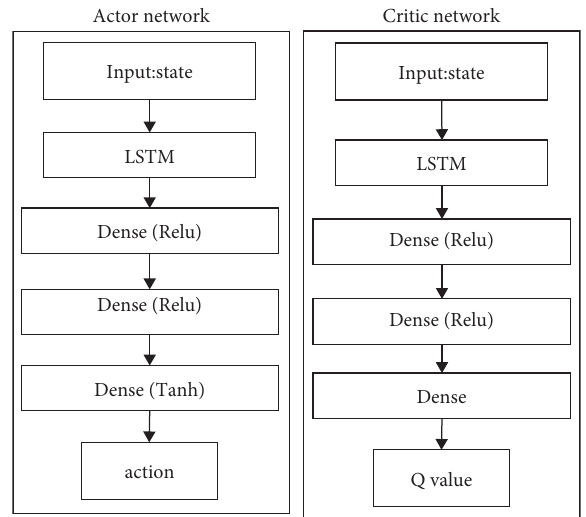
Figure 2: Improved DDPG network